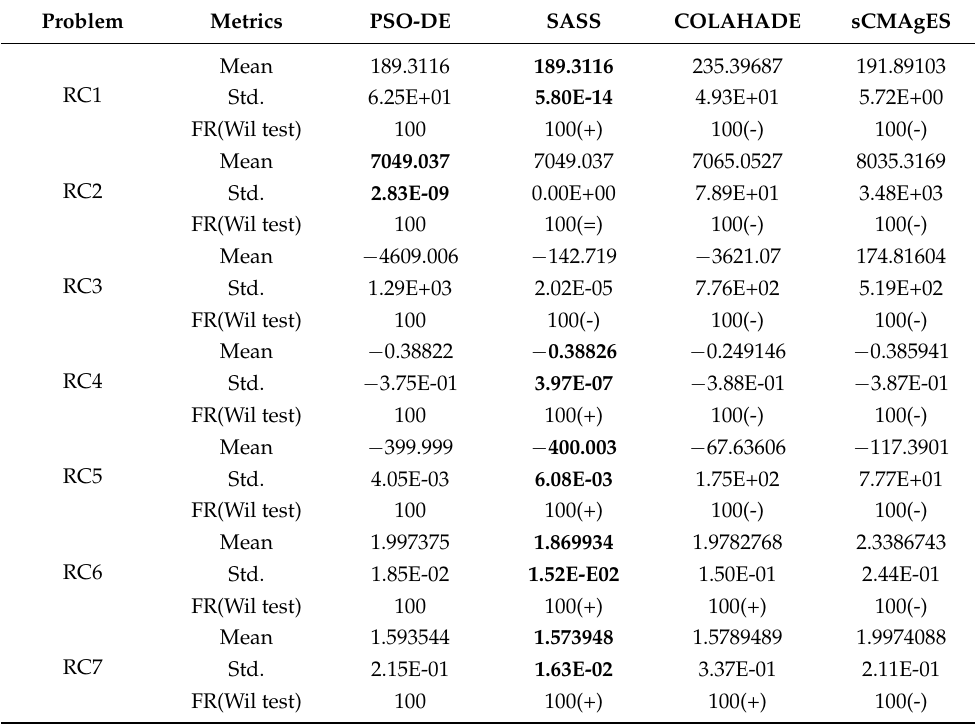
Table 8. Experimental results for industrial chemistry process problems